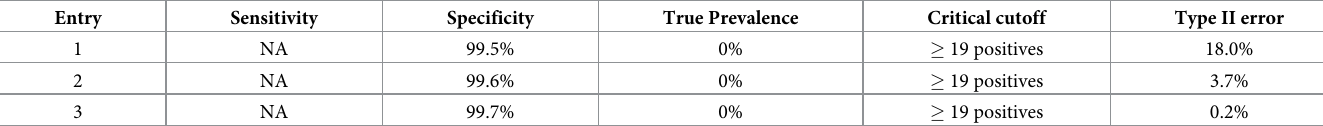
Table 5. Effect of specificity on the Type II error of a 30-cluster survey, where treatment decisions are based on the average prevalence of the entire survey area. No sensitivity assumptions were made. The critical cutoff was � 19 positive tests out of a sample size of 3000. The calculations were made for a true prevalence of 0%. At least 99.6% specificity is required to have a Type II error of < 10%.